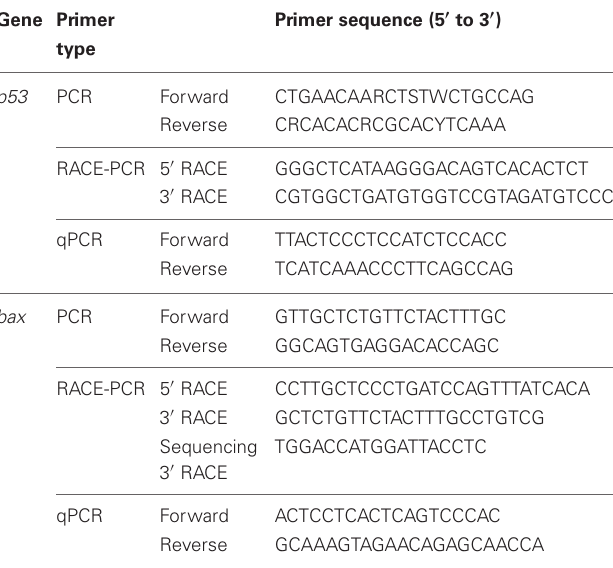
Table 1 | Primers for PCR or RACE PCR to amplify or quantitative RT-PCR to quantify mRNA expression of p53 or Bcl-2 associated X protein ( bax ) from the gills of Anabas